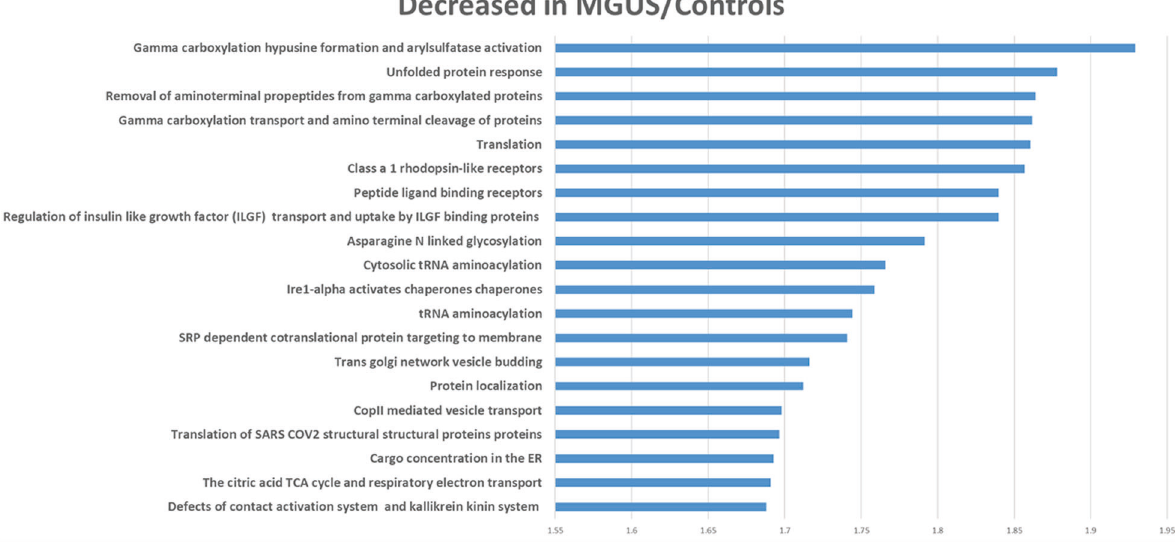
Fig. 4 Gene set enrichment analyses of proteins in smoldering and active myeloma samples compared to MGUS and control samples (only the top 20 pathways are reported). The values on the X axis are normalized enrichment scores and all were signi fi cant at an FDR corrected p value of